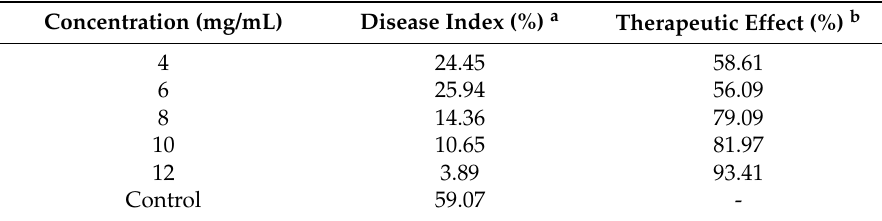
Table 7. Assay of the therapeutic effect of BAEO against Gloeosporium orbiculare .